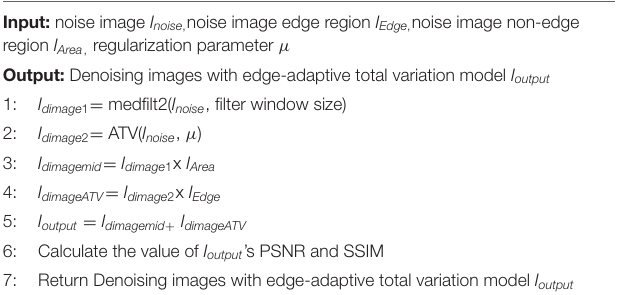
Algorithm 3 : Image sub-regional denoising and